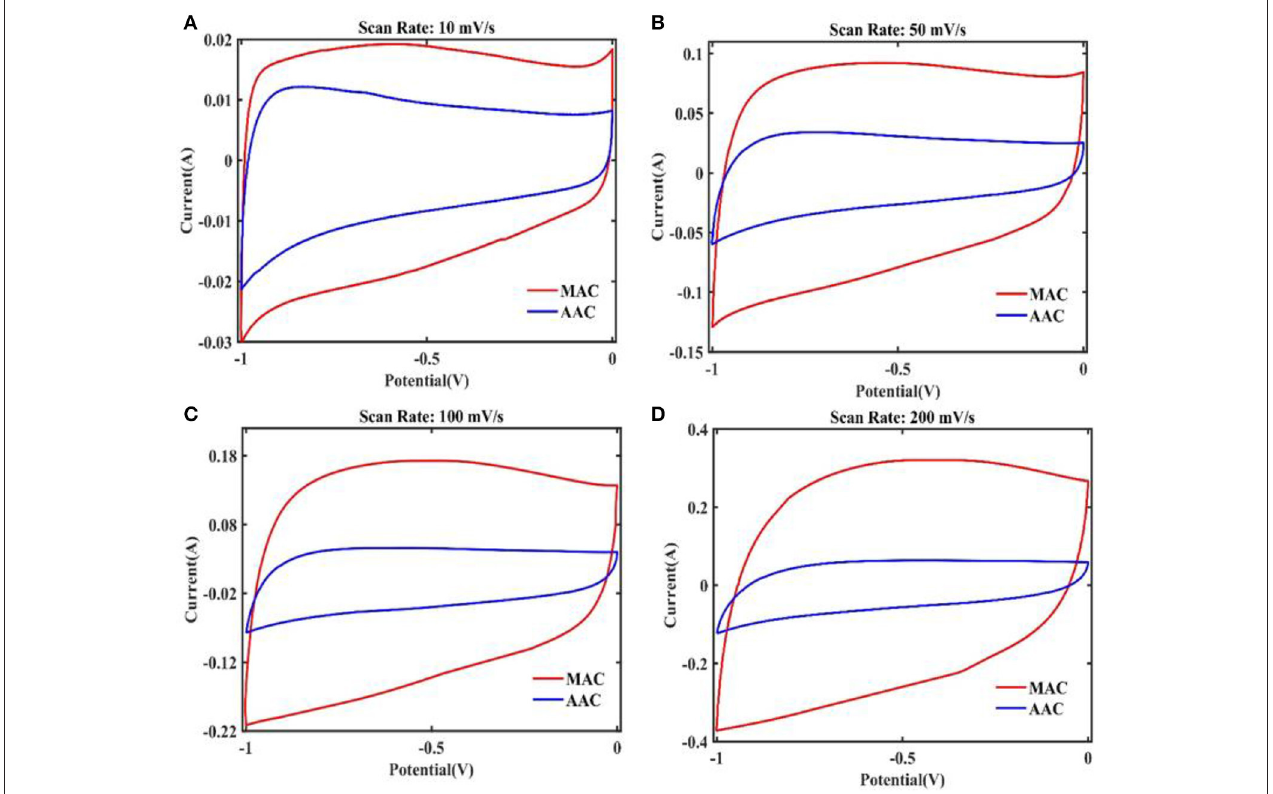
FIGURE 5 | The CV curves of MAC and AAC at the scan rates of (A) 10 mV/s, (B) 50 mV/s, (C) 100 mV/s, and (D) 200 mV/s.